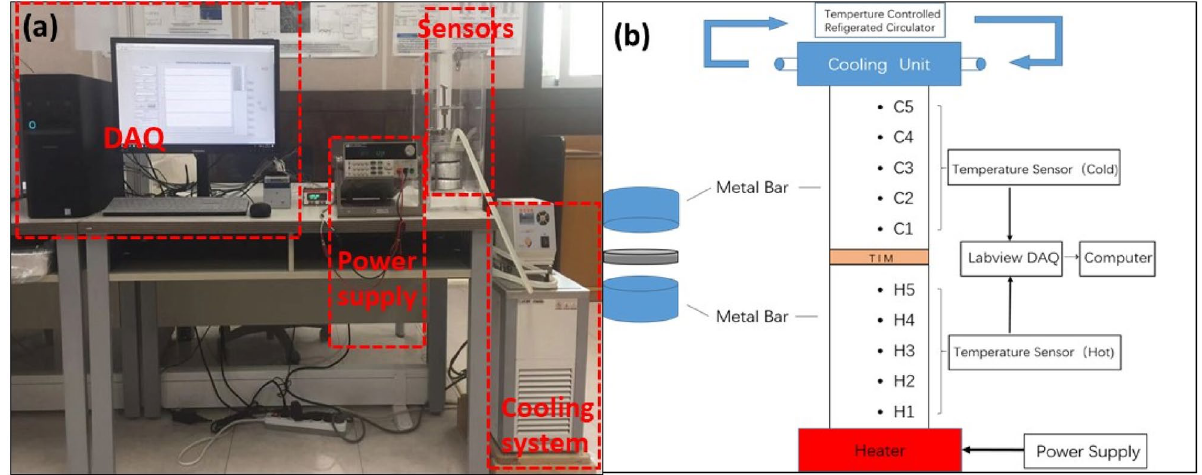
Figure 2. ( a ) Test system for thermal conductivity and ( b ) general features of apparatus used in this